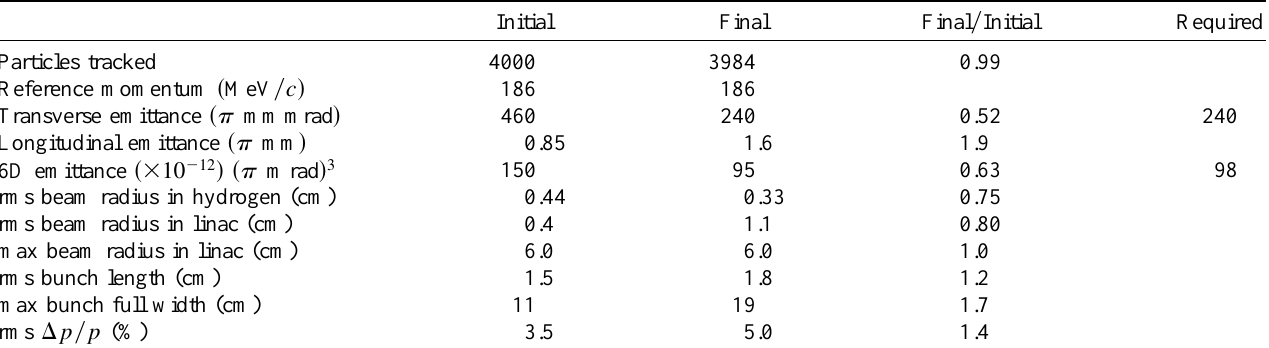
TABLE VI. Initial and final beam parameters in a 31 T transverse cooling section.